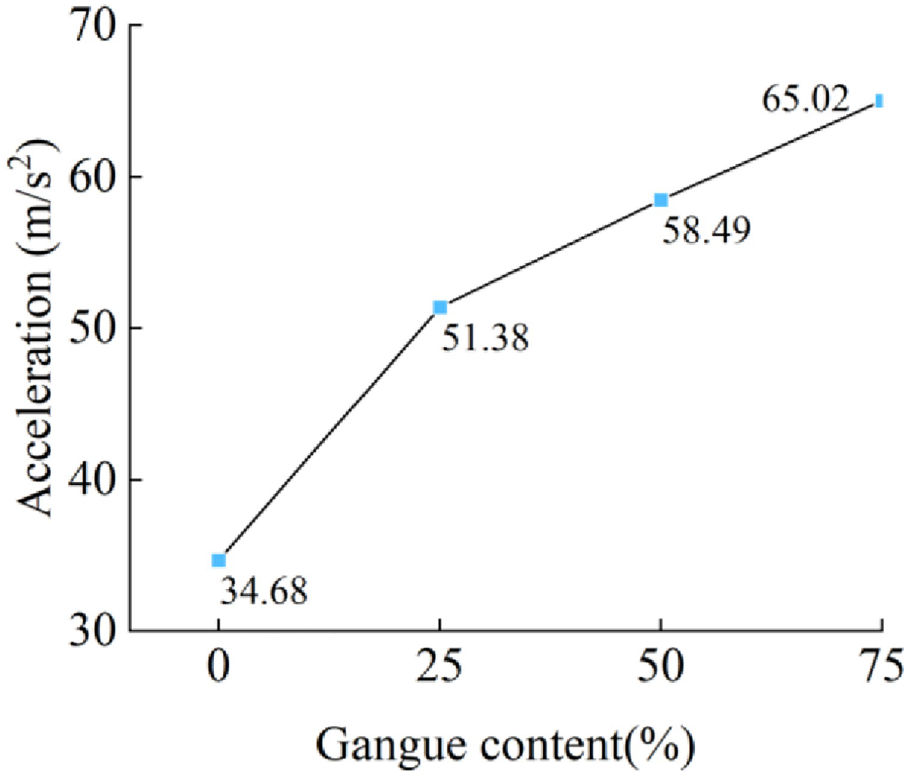
Fig 13. Gangue content versus the effective value of acceleration